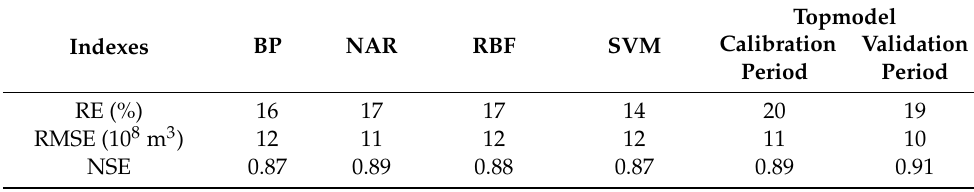
Table 1. Evaluation indexes for the results of the five simulated models.